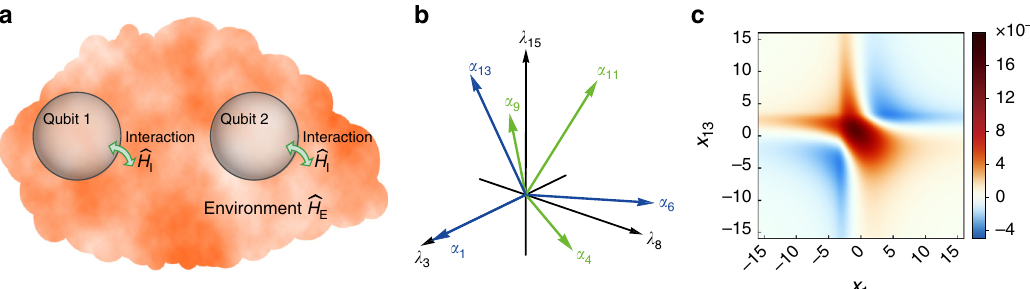
fi ne a new set of random variables. The other three